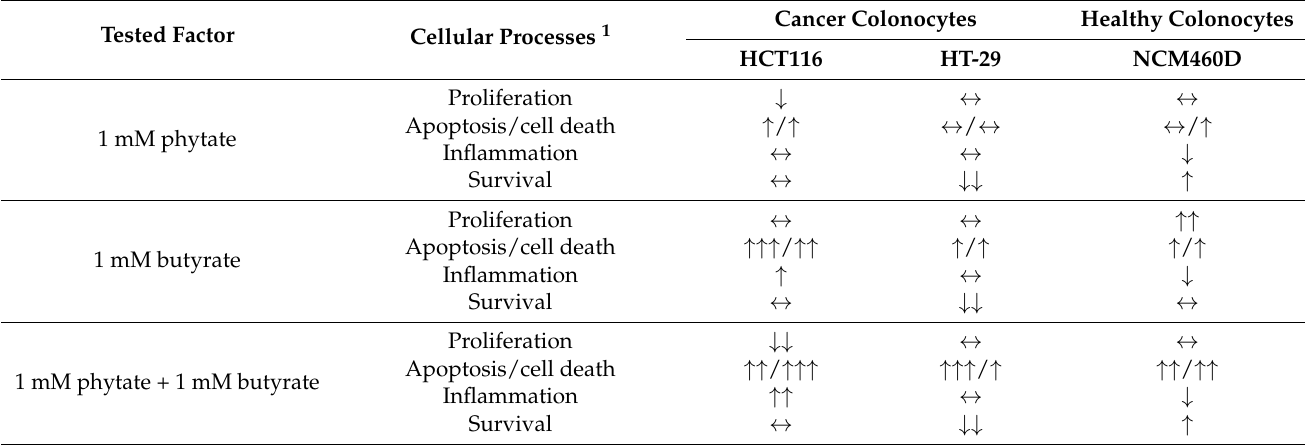
Table 2. The effect of 1 mM phytate and/or 1 mM butyrate on cellular processes in cancer and healthy human colonocytes. Tested